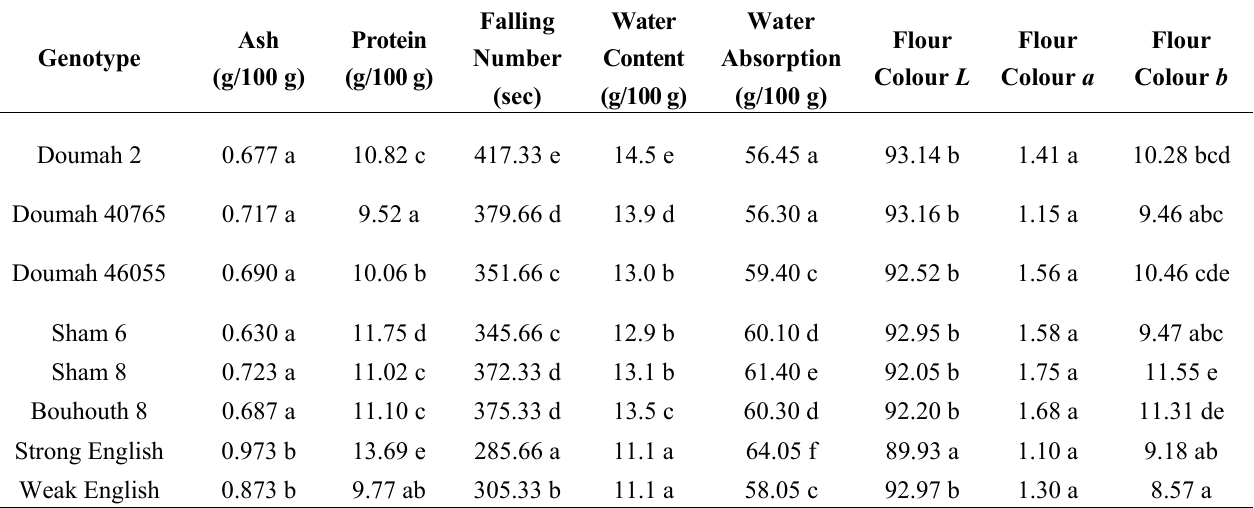
Table 5. Chemical characteristics of wheat flour